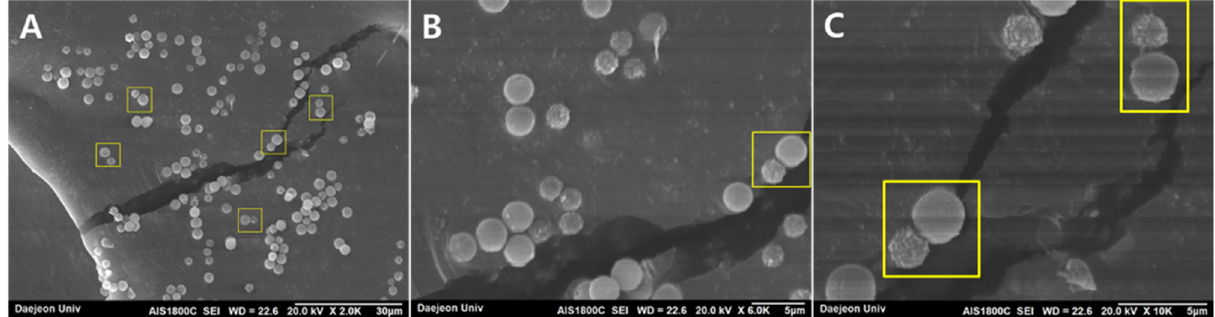
Figure 4. SEM images of microparticles of the middle portion of PEG-DEX ATPS after the EDC coupling reaction with different magnifications. ( A ) 2000 times, ( B ) 6000 times, ( C ) 10,000 times magnified. Janus dumbbell particles are shown in yellow boxes. Scale bars are ( A ) 30, ( B ) 5, ( C ) 5 μm. See Experimental for other conditions.